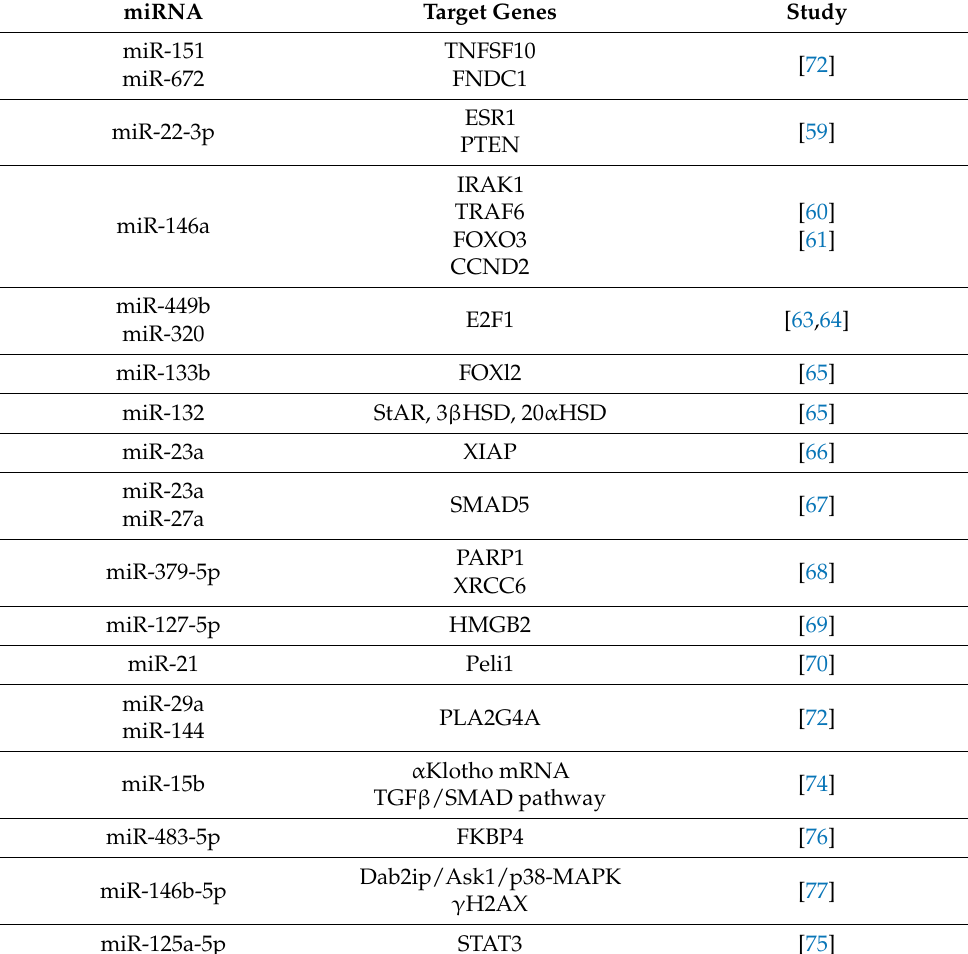
Table 2. The most common miRNAs involved in the pathophysiology of POI. miRNA Target Genes Study